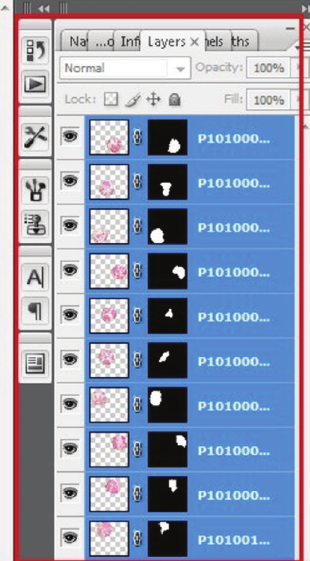
Figure 9: On “photomerge” command, notice how the software integrates multiple layers and stitches into one. One can observe this on layers panel. Note the red boxes in the figure. Follow them for an easy